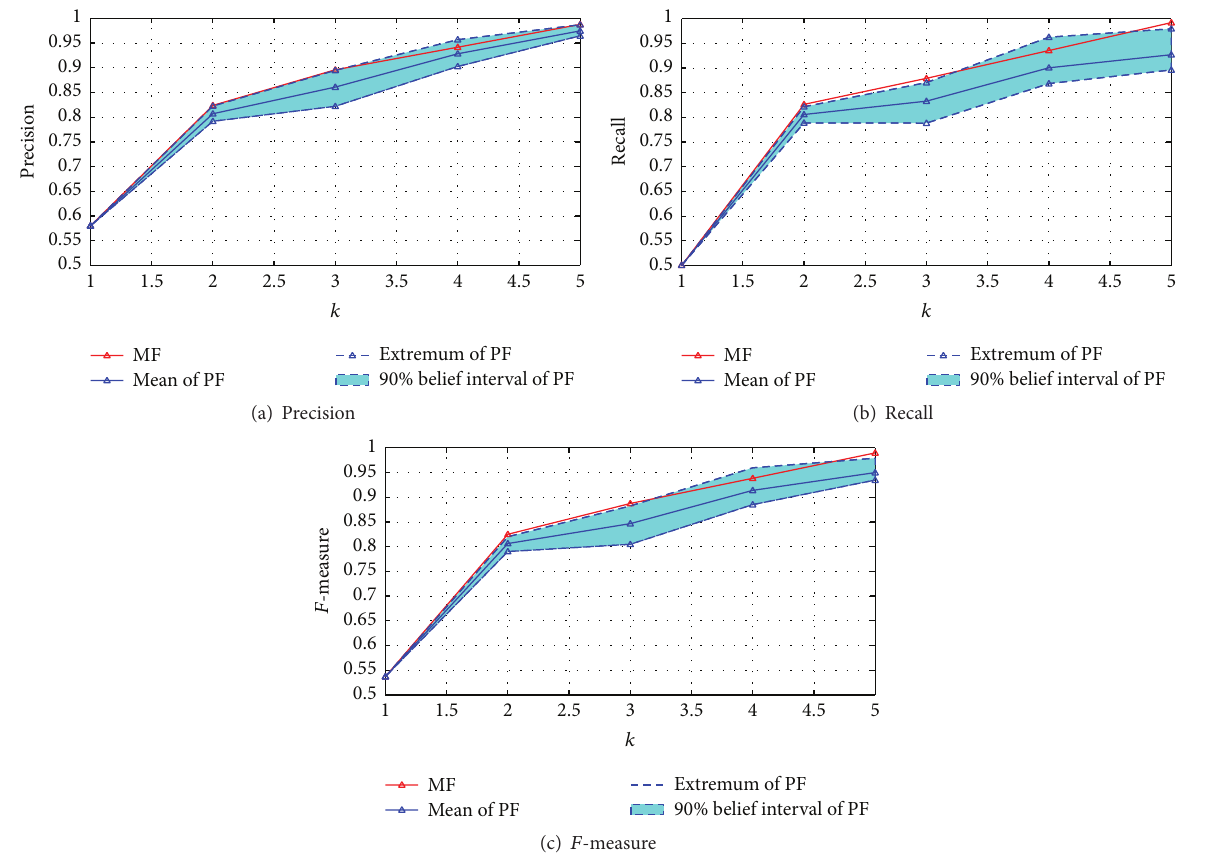
Figure 6: Metrics of the PF with 6000 particles and the